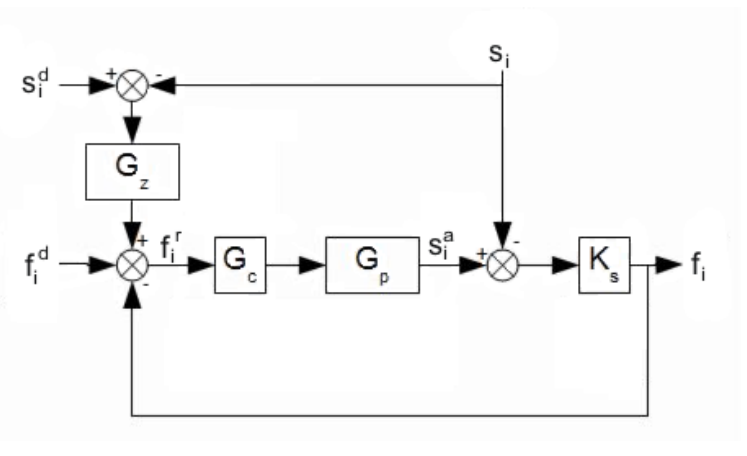
Figure 18. SEA compliance control scheme block diagram.